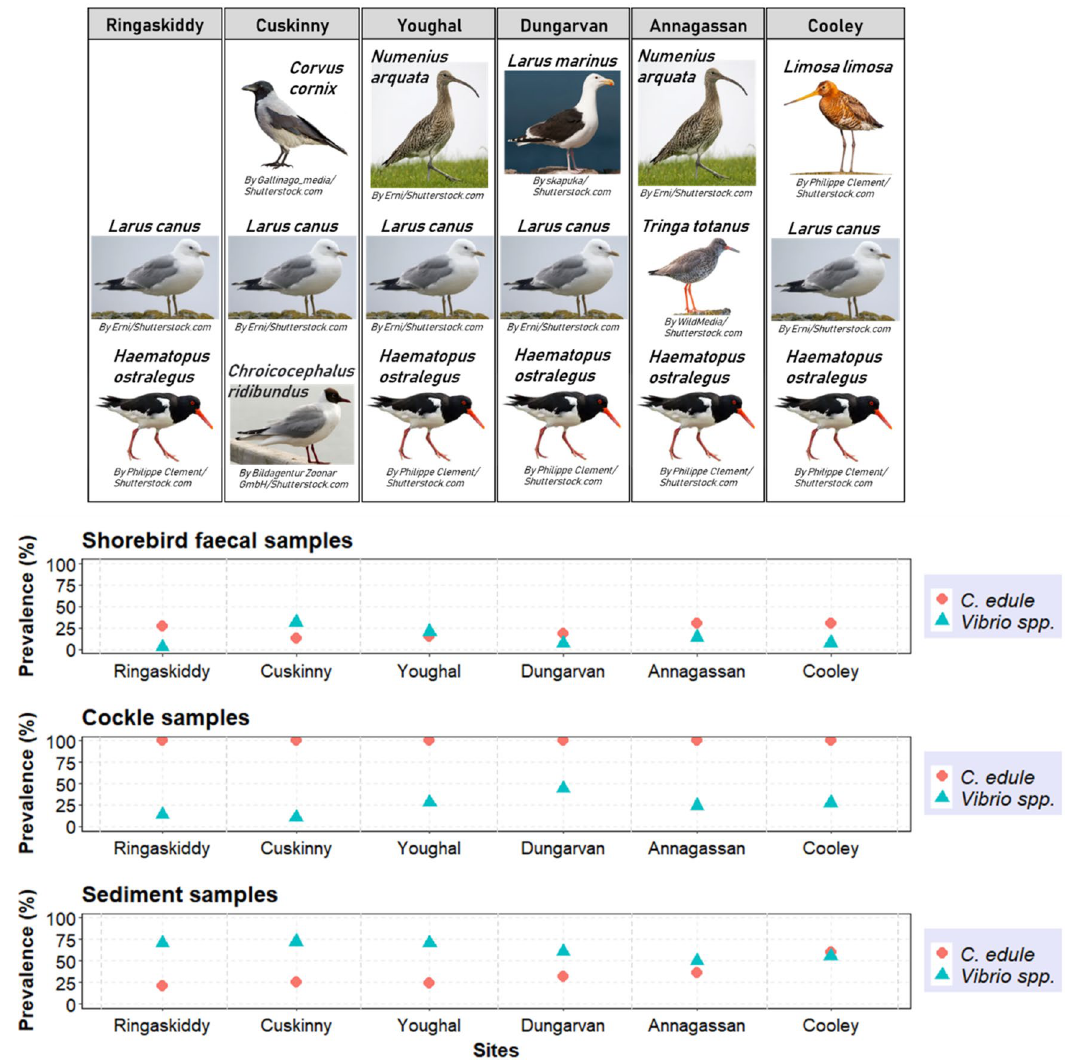
Figure 2. Distribution of C. edule DNA compared to the presence of Vibrio spp. in shorebird faecal samples, cockles, and sediment samples at each sample site. The most frequently observed shorebird species throughout the seasons at each sample site are represented on the top of the figure (Images used under license from